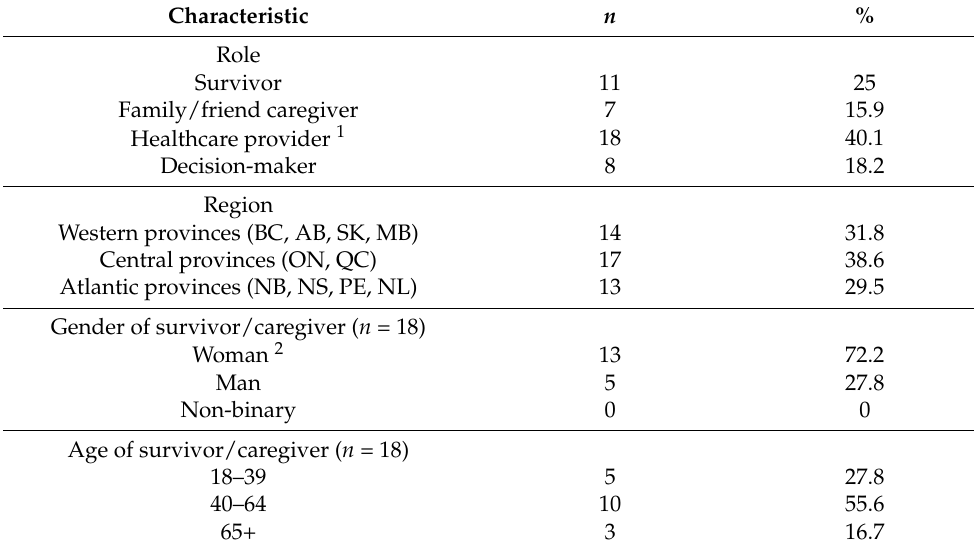
Table 1. Participant characteristics ( n =